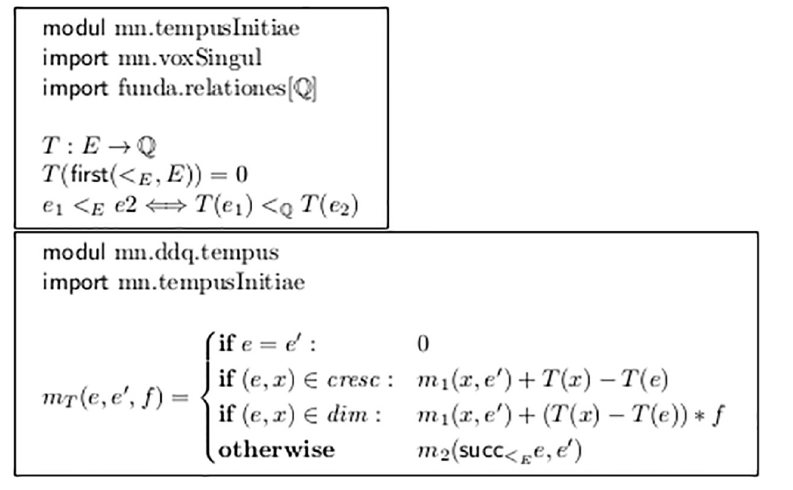
Fig 19. Considering events’ temporal start